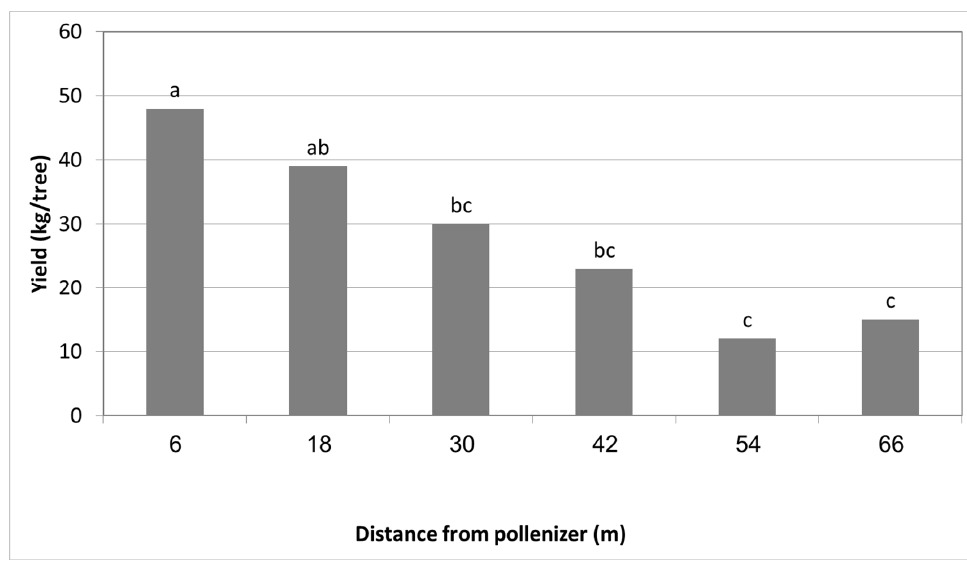
Figure 1. The effect of increasing distance from the pollinizer HL on the yield of MA, Ravid 2017. Mean values of each column (distance) followed by different letters differ significantly per Duncan’s new multiple range test, p < 0.05. Data of each column are the means of 6 replicate trees per treatment (distance). (Figure 2). The yield of MA in the closest row to HL was 48 kg/tree, whereas in the closest row of MA to KA or NMC it was 35 kg/tree, similar to the self-pollinated control. Moreo- ver, MA fruit from trees adjacent to HL were larger and reached 24.5 g per fruit compared